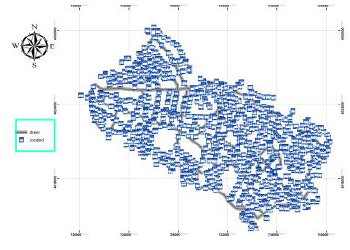
Figure. 8 Distribution of bus stations in Mashhad